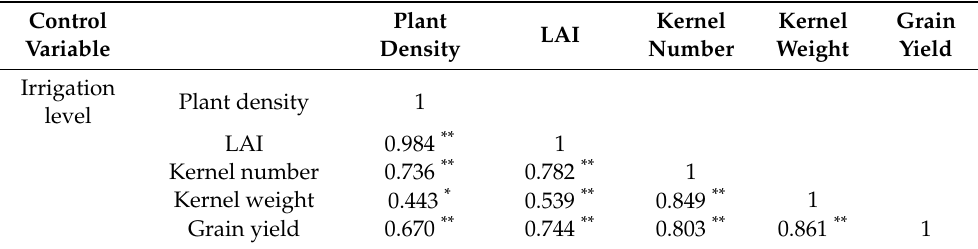
Table 4. Correlation among plant density, LAI, kernel number, kernel weight, and grain yield of maize under irrigation level in 2016 and 2017.